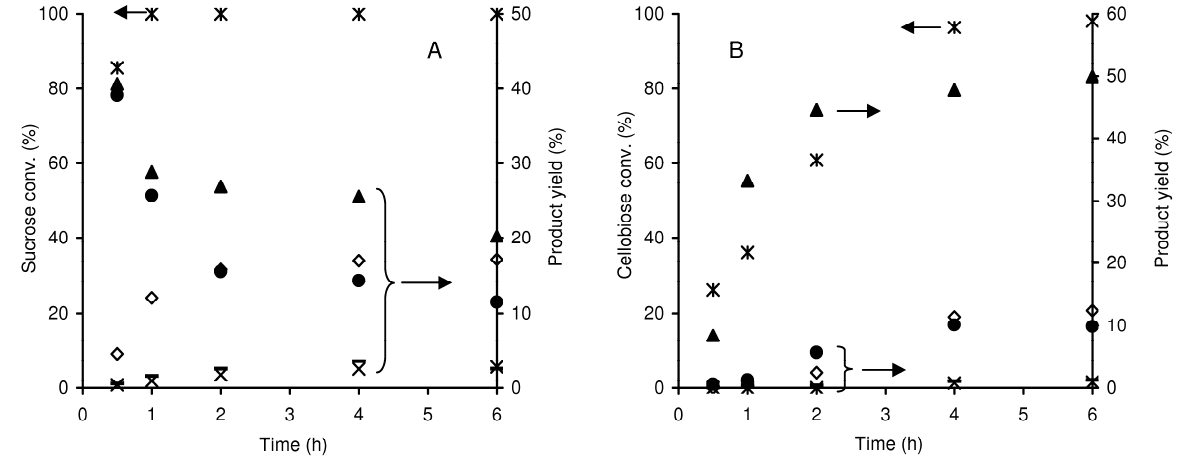
Figure 9. Reaction of sucrose (A) and of cellobiose (B), in the presence of Al-TUD-1 at 170 ºC: (*) disaccharide conversion; ( ● ) fructose yield, ( ▲ ) glucose yield; (  ) HMF yield; ( − ) mannose yield; ( × ) FUR yield.